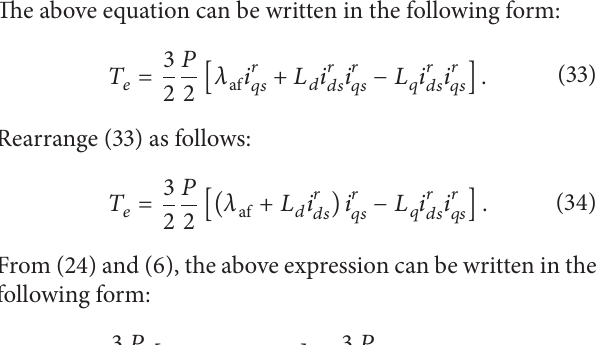
Figure 2: Performance characteristics of PMSM for constant torque angle